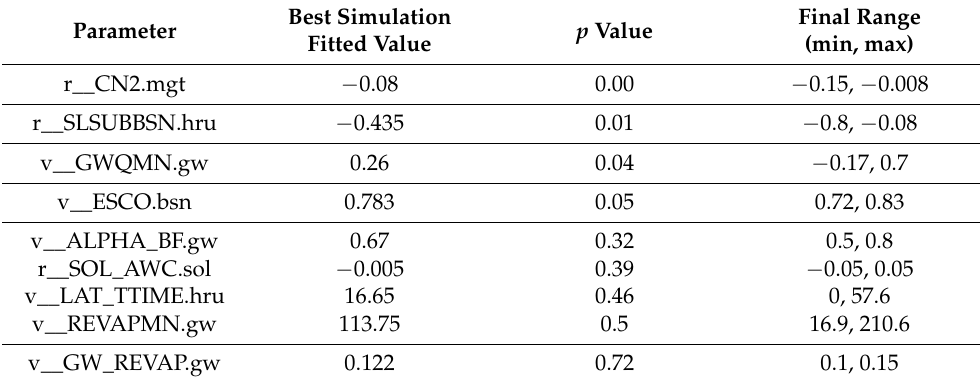
Table 4. Parameters used in calibration